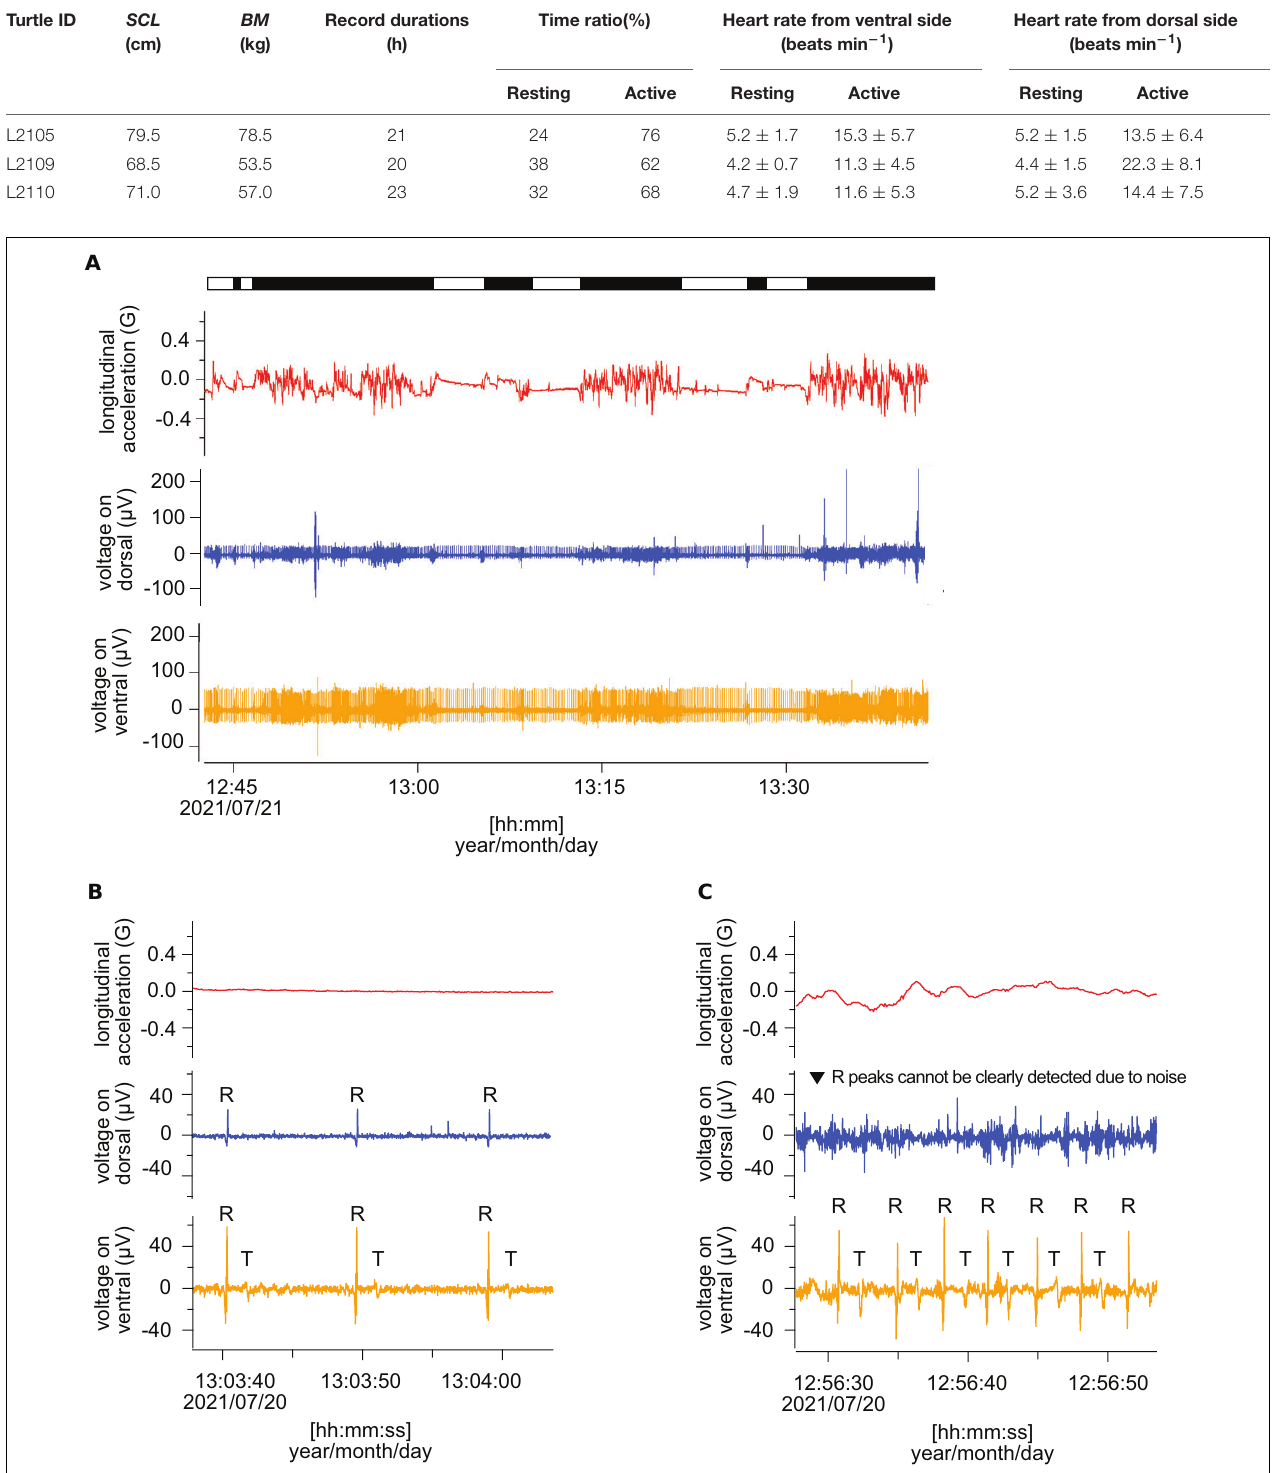
Heart rate from dorsal side (beats min − 1 )